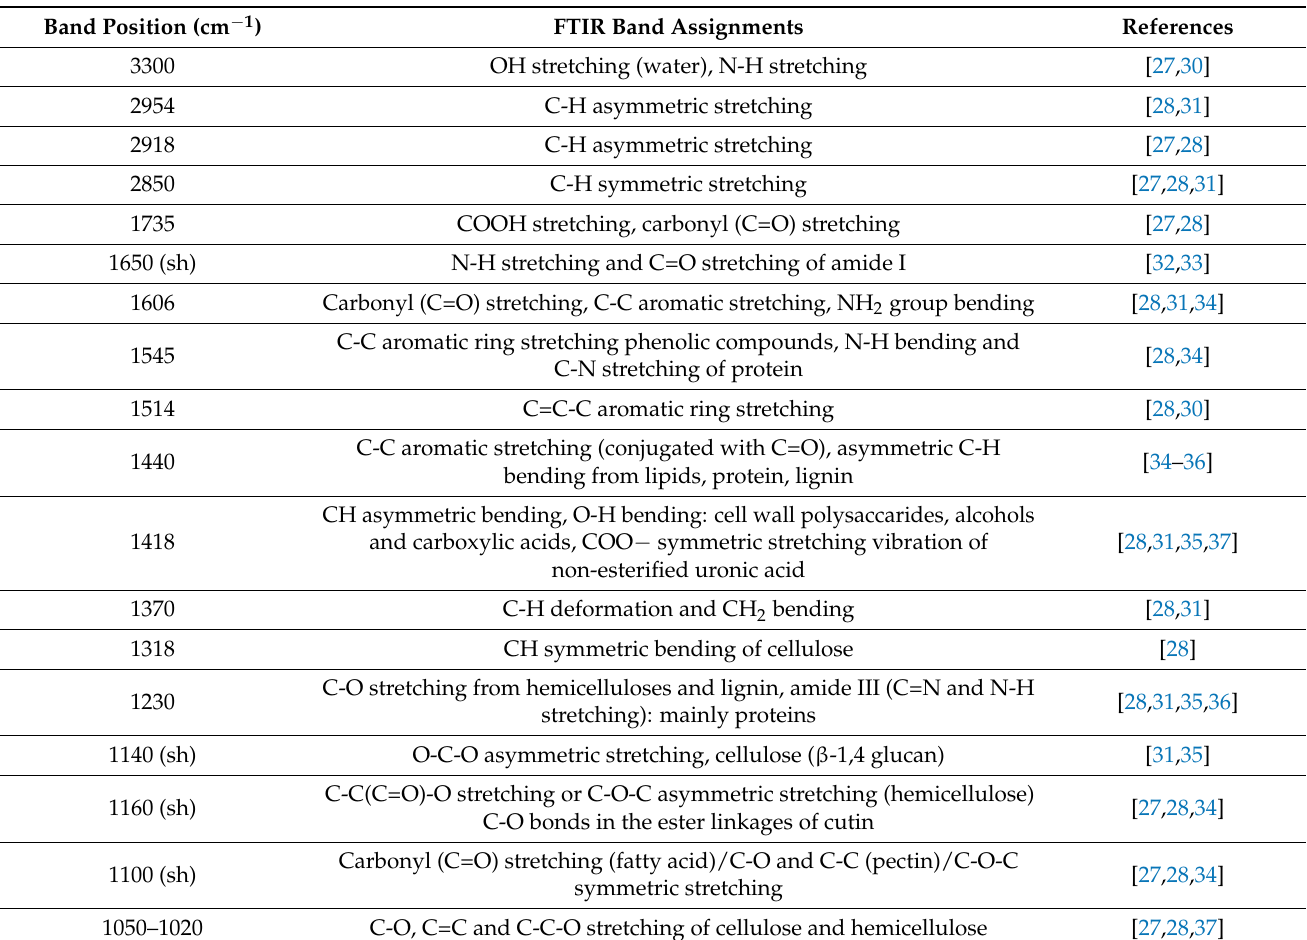
Table 2. FTIR band assignments of the control